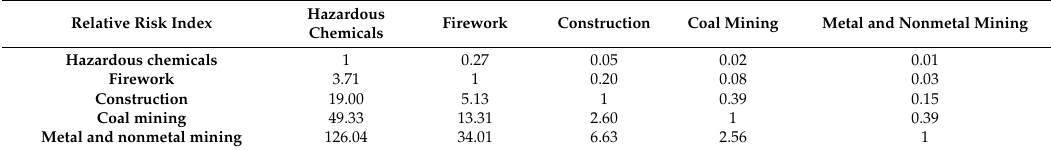
Table 3. Relative risk index between five high-danger industries during the 11 th FYP in China.